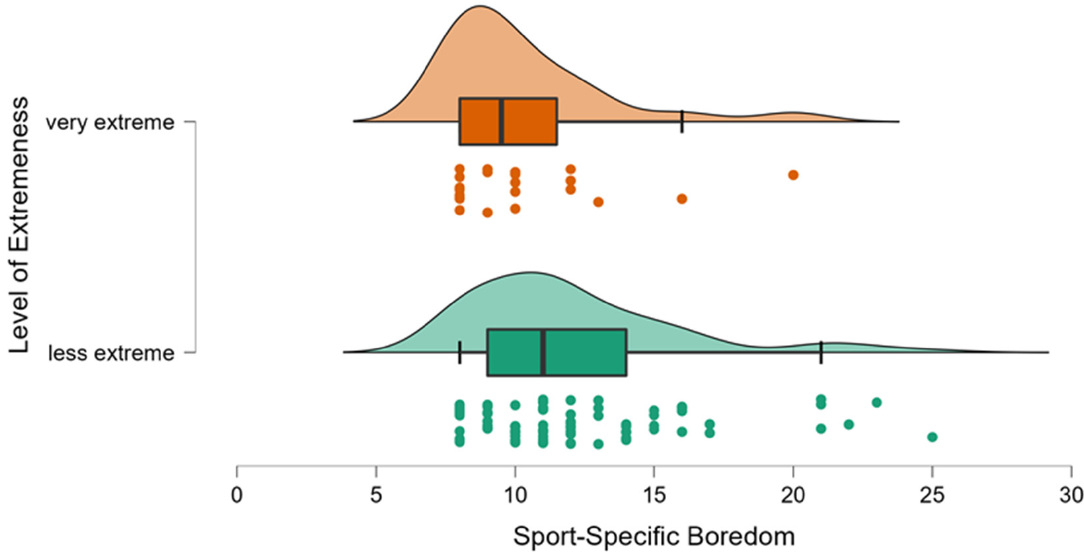
Figure 2. Raincloud plots comparing the ultra-endurance athletes (denoted as “very extreme”) with their “less extreme” peers.